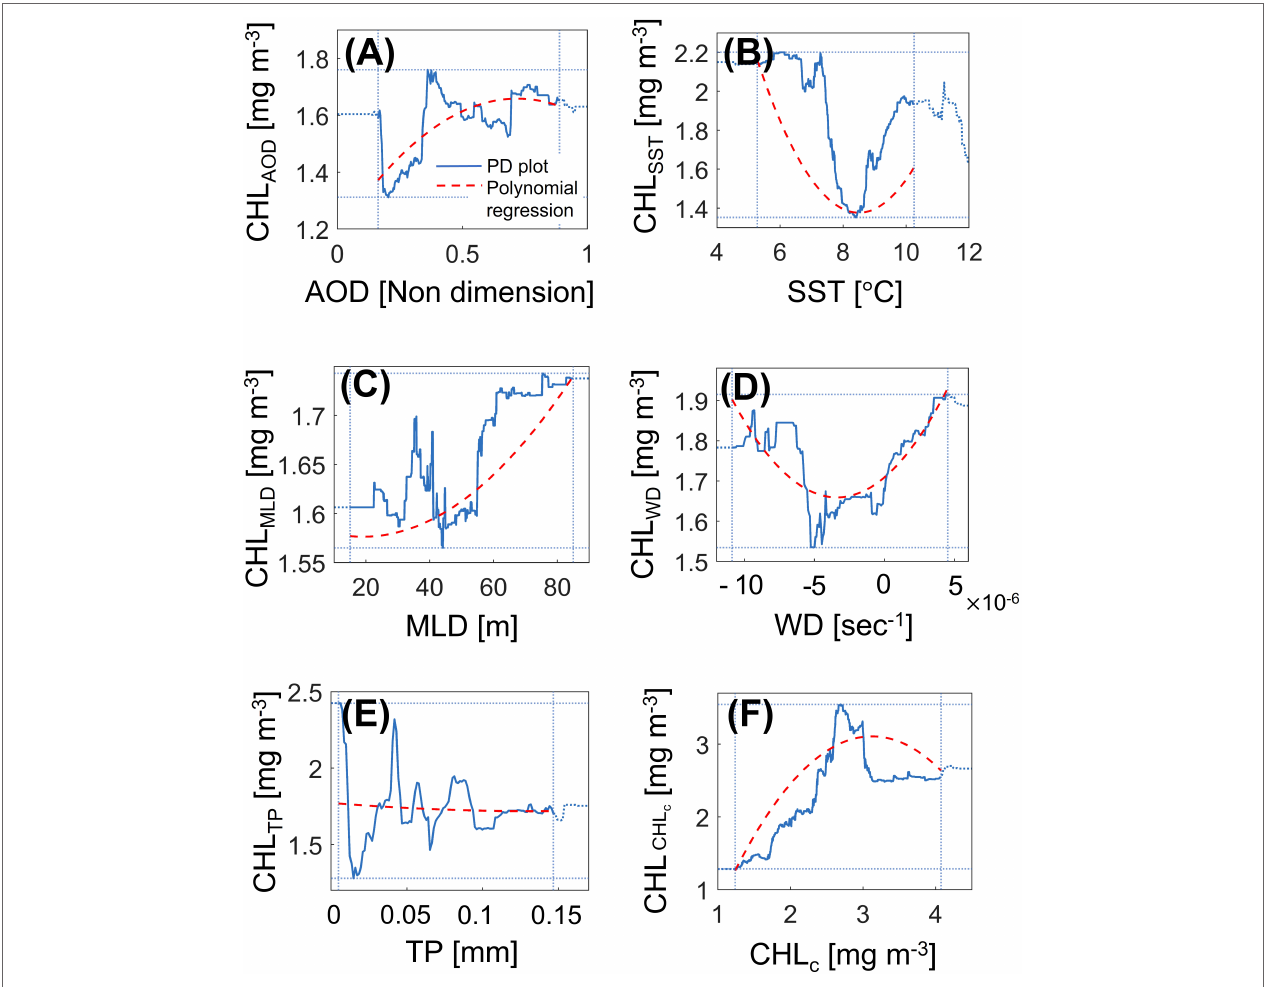
FIGURE 6 | Partial dependence (PD) plots of the CHL for all predictors including AOD, SST, MLD, WD, TP, and CHL C . The blue dotted lines show PD plots and red dashed lines represent the empirical polynomial